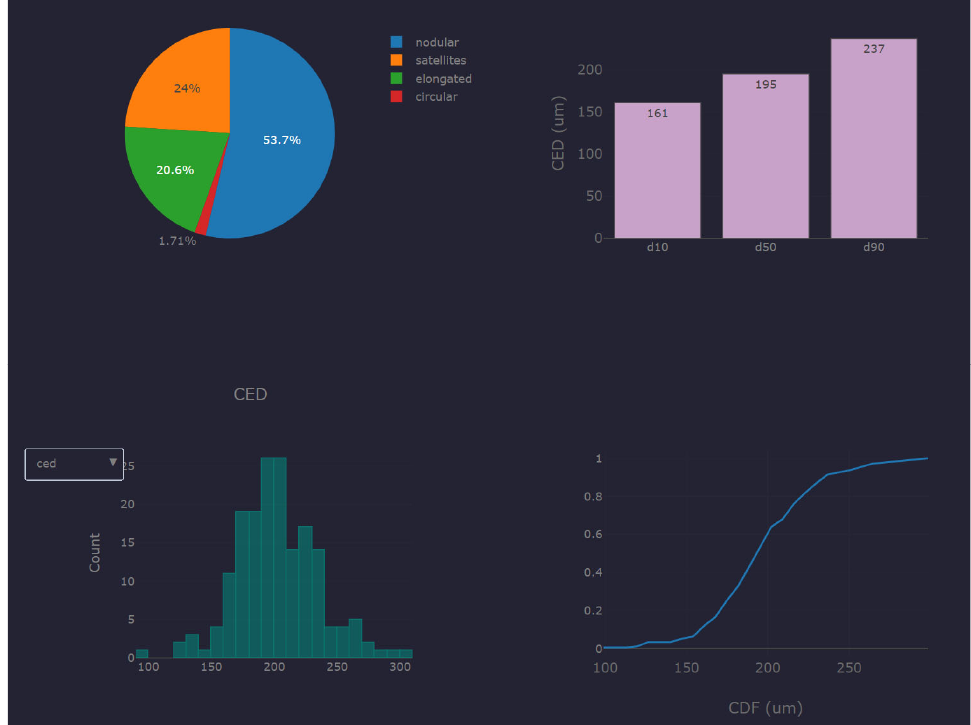
Figure 6. Indicative detection results provided to user for AM particle analysis for a given batch of images.